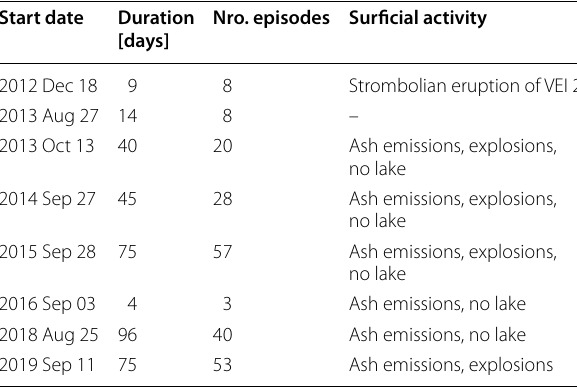
Table 2 Periods of time on which BB tremor emerge in swarms and volcanic activity observed in the crater (Additional files 3,